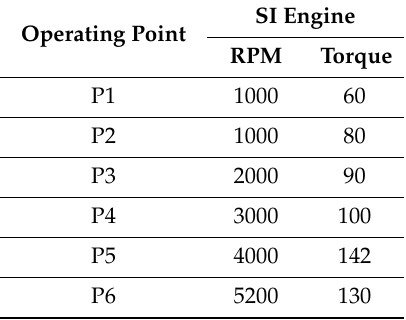
Table 4. Engine operating point for TEG.